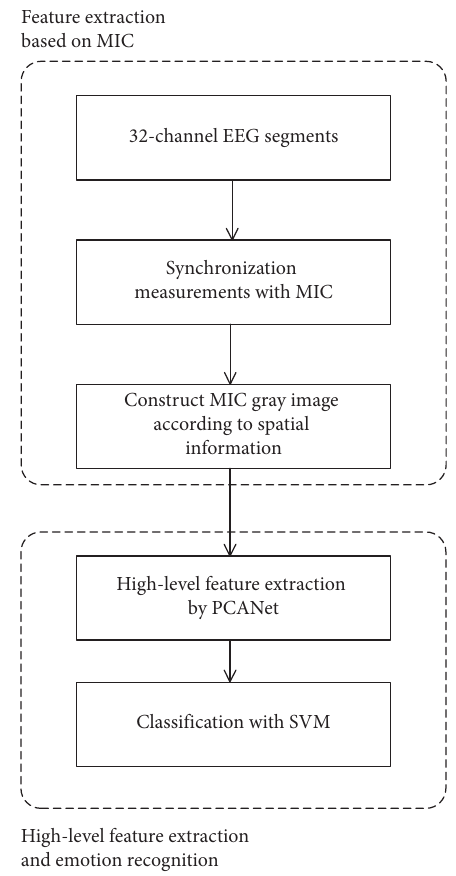
Figure 3: Overview of the proposed approach and its operational